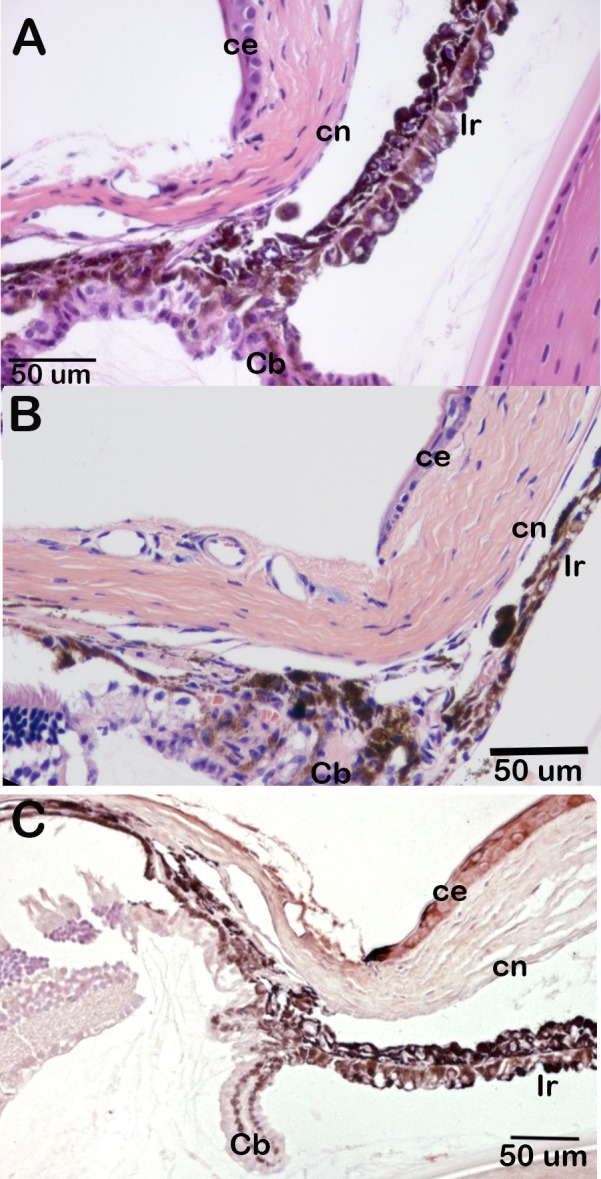
Lack of corneal endothelial cell metaplasia in Csrp2bp haploinsufficient mice.(A) Csrp2bptm1a/+, age 3 months, H &E. (B) Csrp2bpEx/+, age 8 months, H&E. (C) Csrp2bptm1a/+, age 2 months, pan-cytokeratin immunohistochemistry. Ir, iris; ce, corneal epithelium; cn, corneal endothelium; Cb, ciliary body.